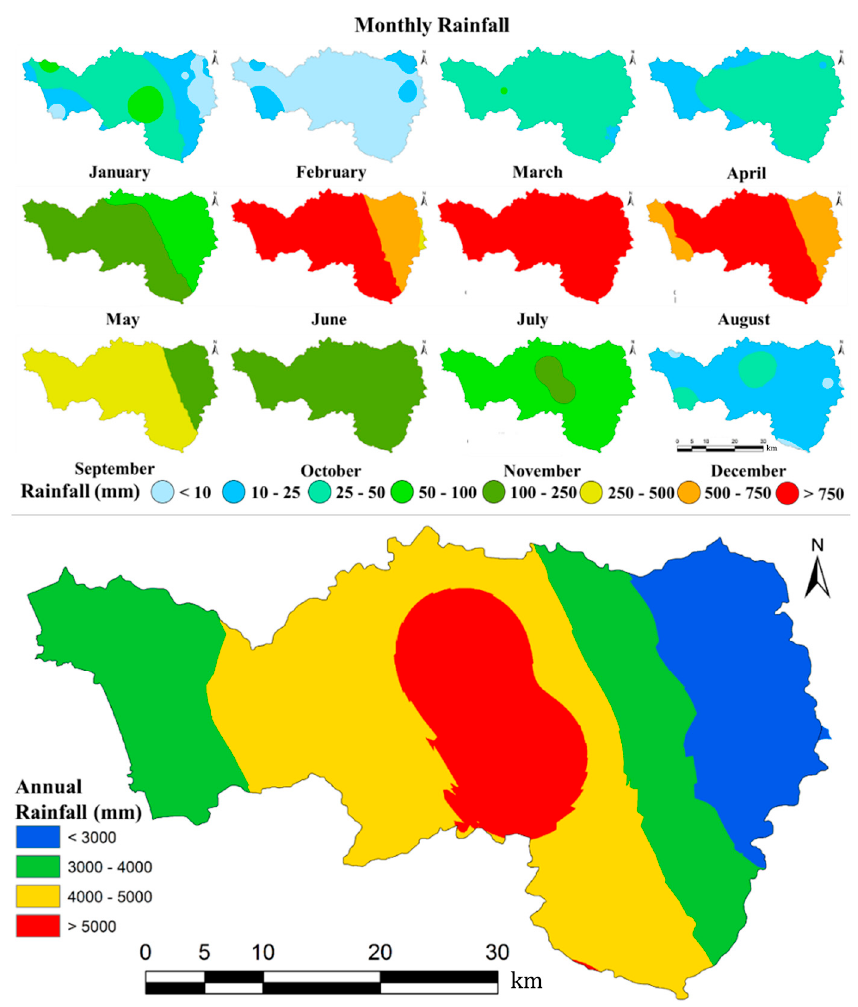
Figure 4. Spatio-temporal rainfall dynamics in the Aghanashini River basin.